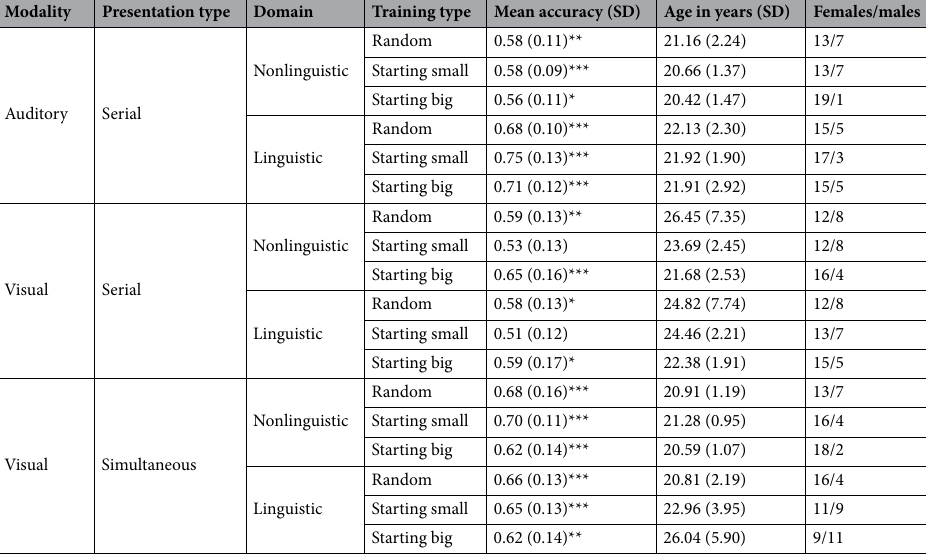
Table 1. Descriptive statistics of groups in different modality, presentation, domain and training conditions. Descriptive statistics of the 2AFC accuracy task in groups in different Modality, Presentation Type, Domain and Training Type conditions. Differences from chance level (0.5) are calculated with one-sample t-tests, *: p < 0.05, **: p < 0.01, ***: p < 0.001. Mean age and proportion of females and males are also displayed for each